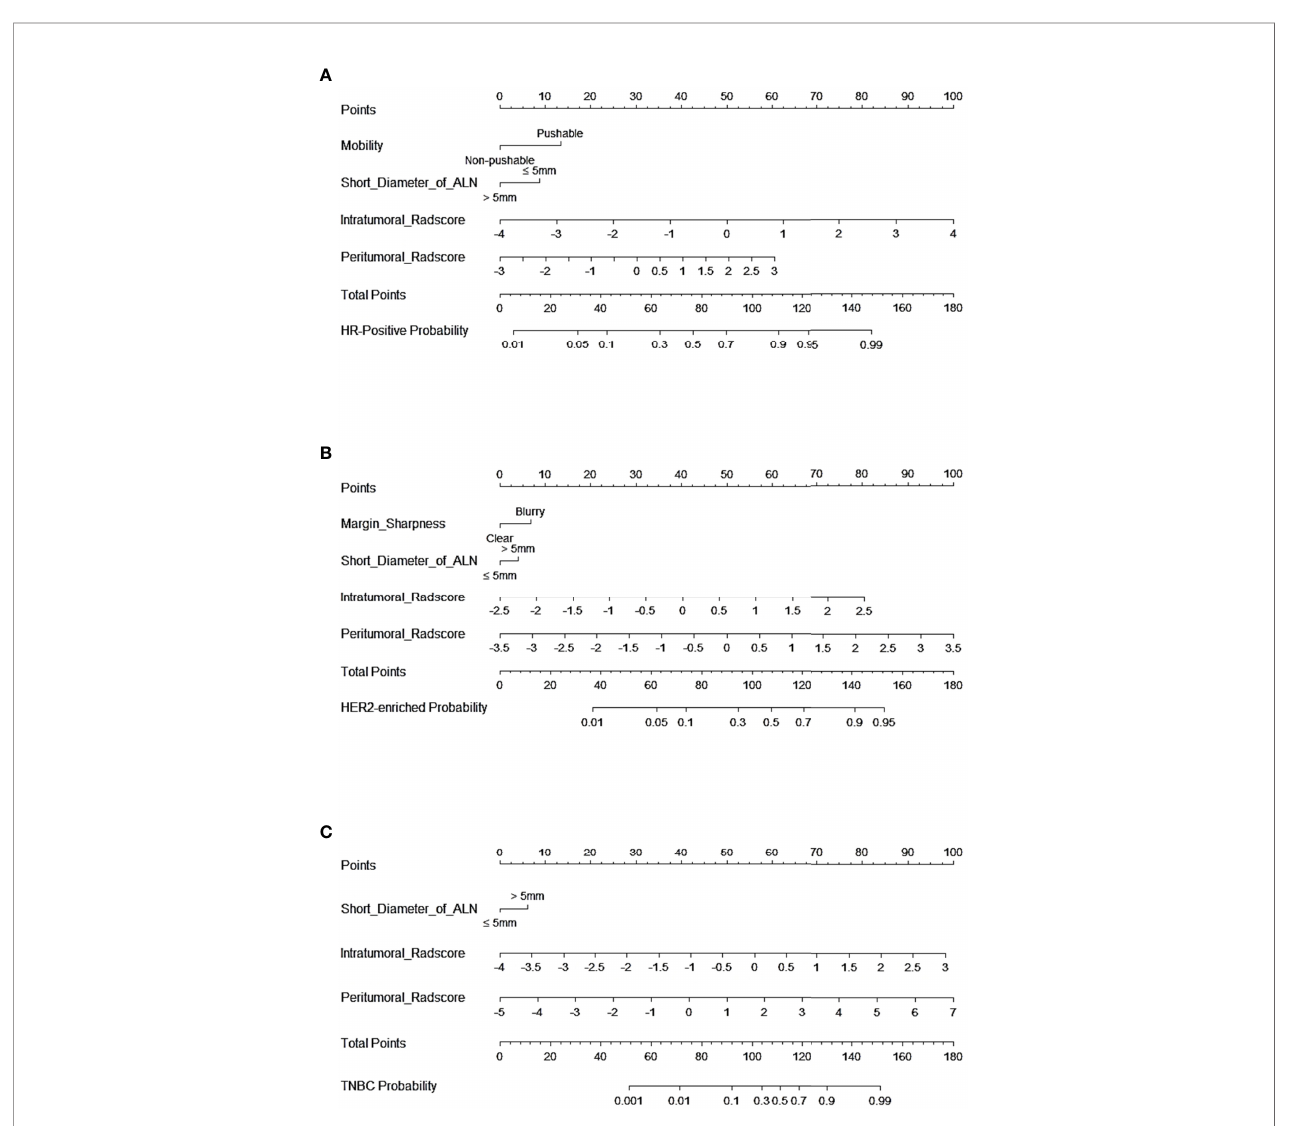
FIGURE 5 | Nomogram of CCRMs in tasks 1 – 3. (A) Nomogram of CCRMs for the prediction of HR-positive and HR-negative in task 1. (B) Nomogram of CCRMs for the prediction of HER2-enriched and non-HER2-enriched in task 2. (C) Nomogram of CCRMs for the prediction of TNBC and non-TNBC in task